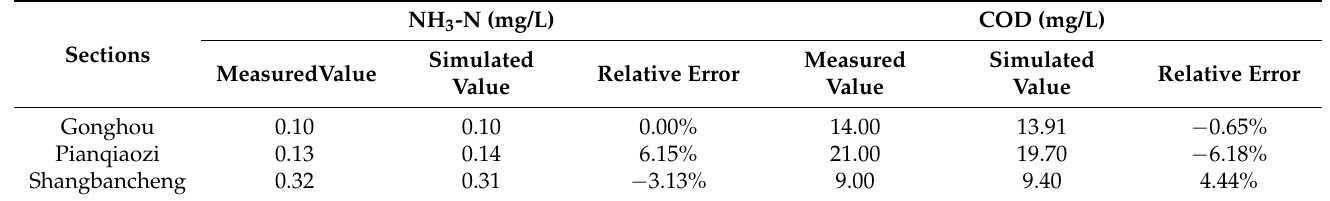
Table 6. Error statistics of NH 3 -N and COD simulation results of the MIKE11 water quality model.